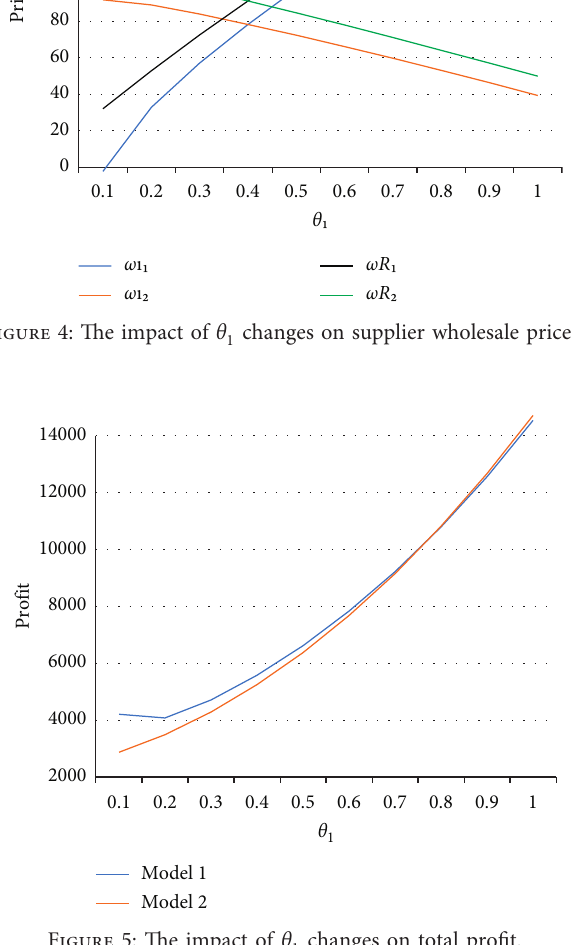
Figure 3: The impact of θ purchase.